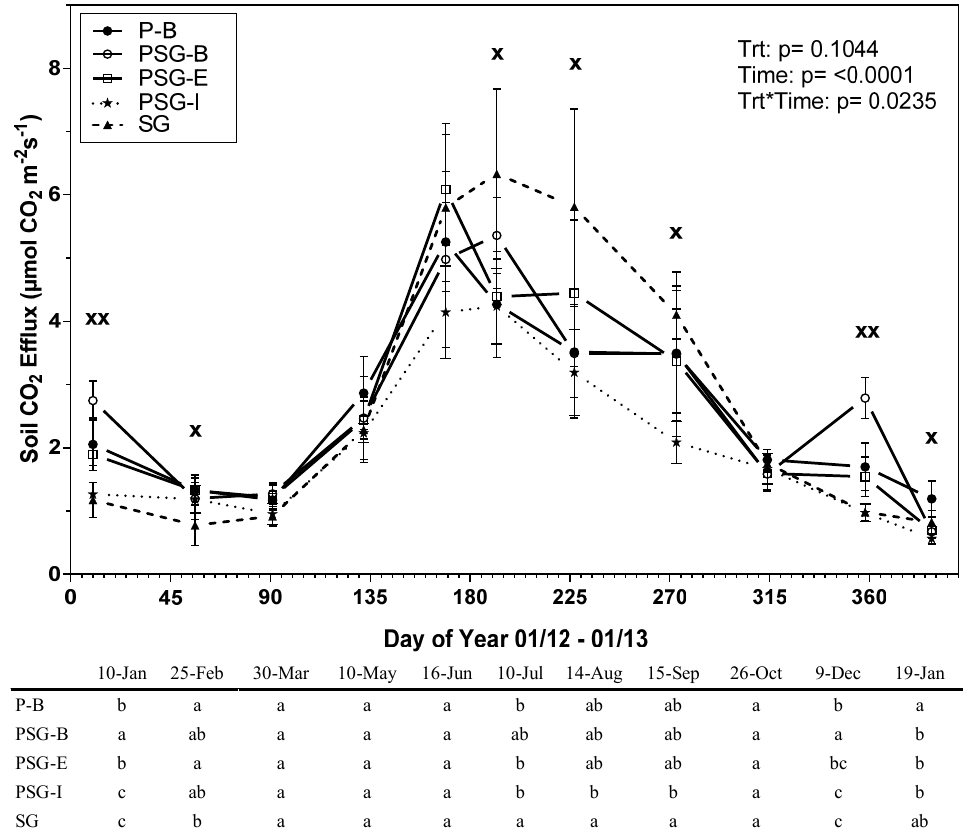
Figure 1. Mean soil CO 2 efflux rates ( µ mol · m − 2 · s − 1 ) from 10 January 2012 to 19 January 2013 in a four-year-old switchgrass and loblolly pine intercropping system on the lower Coastal Plain of North Carolina. Error bars represent ± 1 standard error of the mean. Stars indicate sampling dates with significant differences between treatments as determined using repeated measures analysis ( α = 0.1). The accompanying matrix represents mean separation using Tukey-Kramer HSD where different letters for each treatment date indicate significant differences. Terms with a single asterisks (*) are significant at the p < 0.1 level, double asterisks (**) at p < 0.05. P = pine, SG = flat planted switchgrass, and PSG = pine intercropped with switchgrass. Additional treatment designations indicate the microtopographical position of the sample location where B = bedded row, I = interbed space, and E = edge where an aboveground transition from switchgrass to pine was observed.